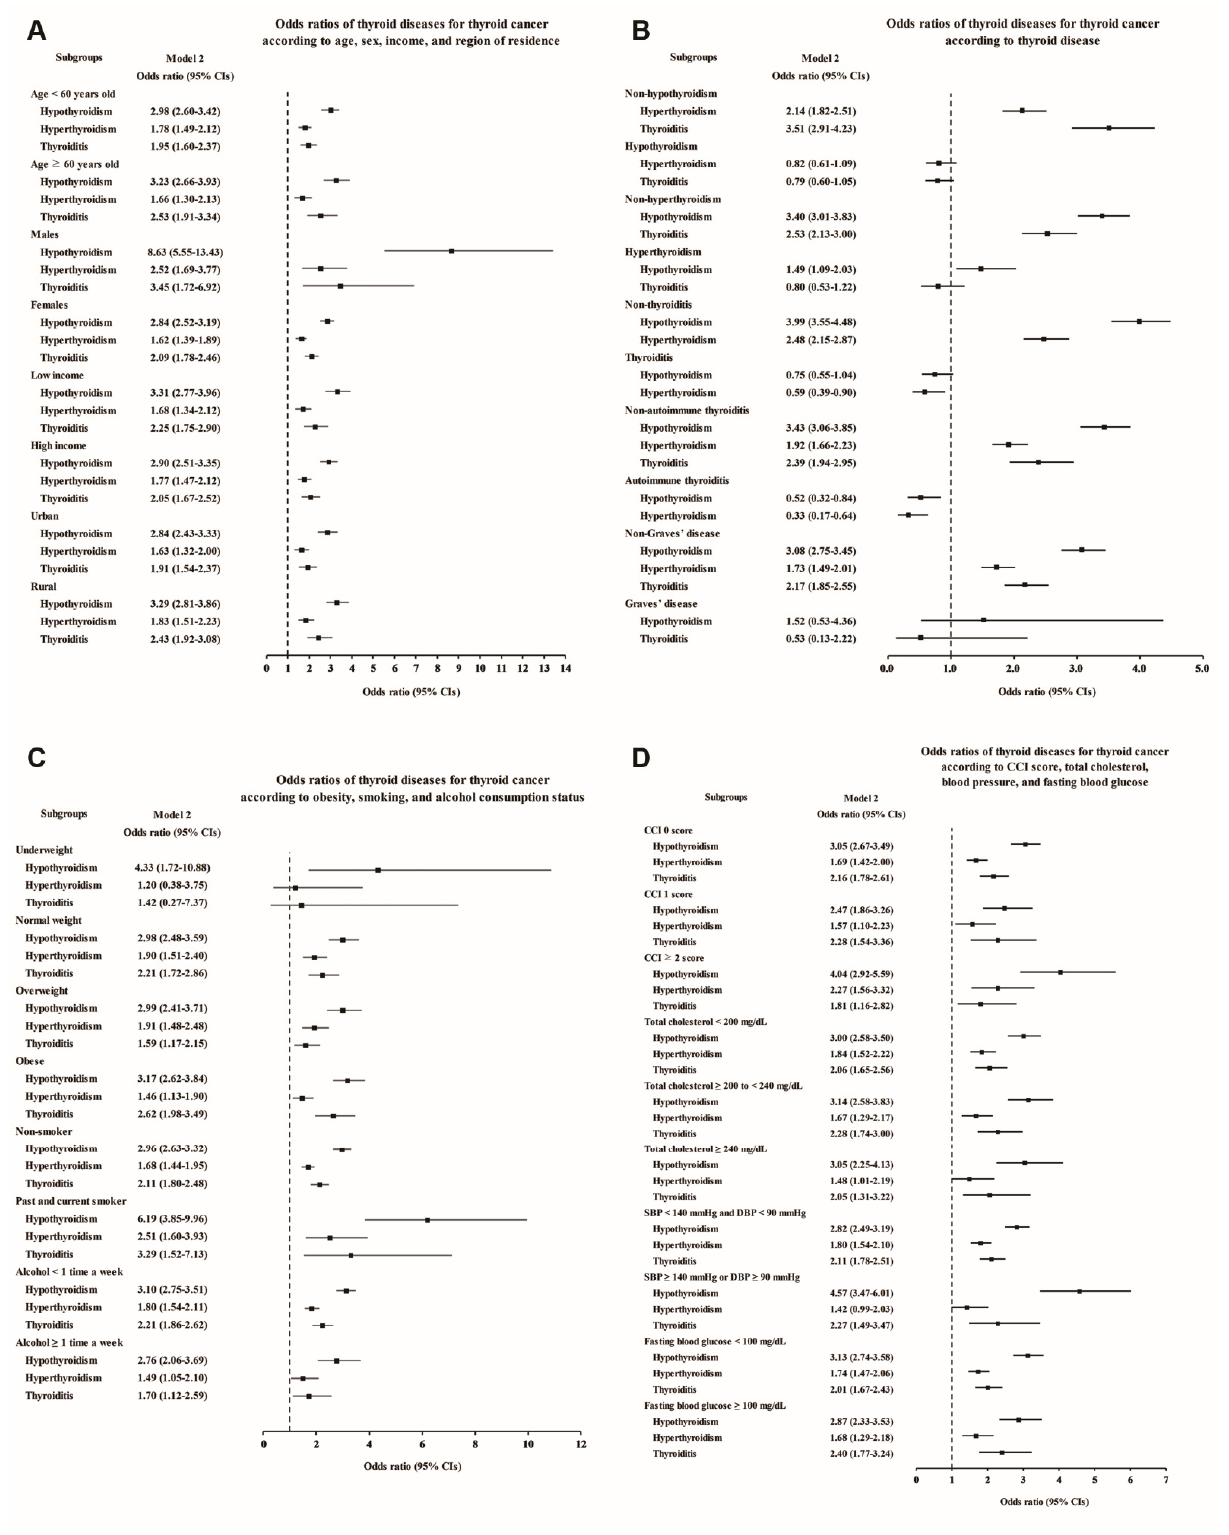
Figure 2. Adjusted odds ratios for thyroid cancer in the subgroup analyses of Study I. The subgroup analyses by ( A ) age, sex, income, and region of residence, ( B ) hypothyroidism, hyperthyroidism, thyroiditis, autoimmune thyroiditis, and Graves’ disease, ( C ) obesity by BMI, smoking status, and frequency of alcohol intake, and ( D ) CCI, total cholesterol, SBP, DBP, and fasting blood glucose. CCI, Charlson comorbidity index; SBP, systolic blood pressure; DBP, diastolic blood